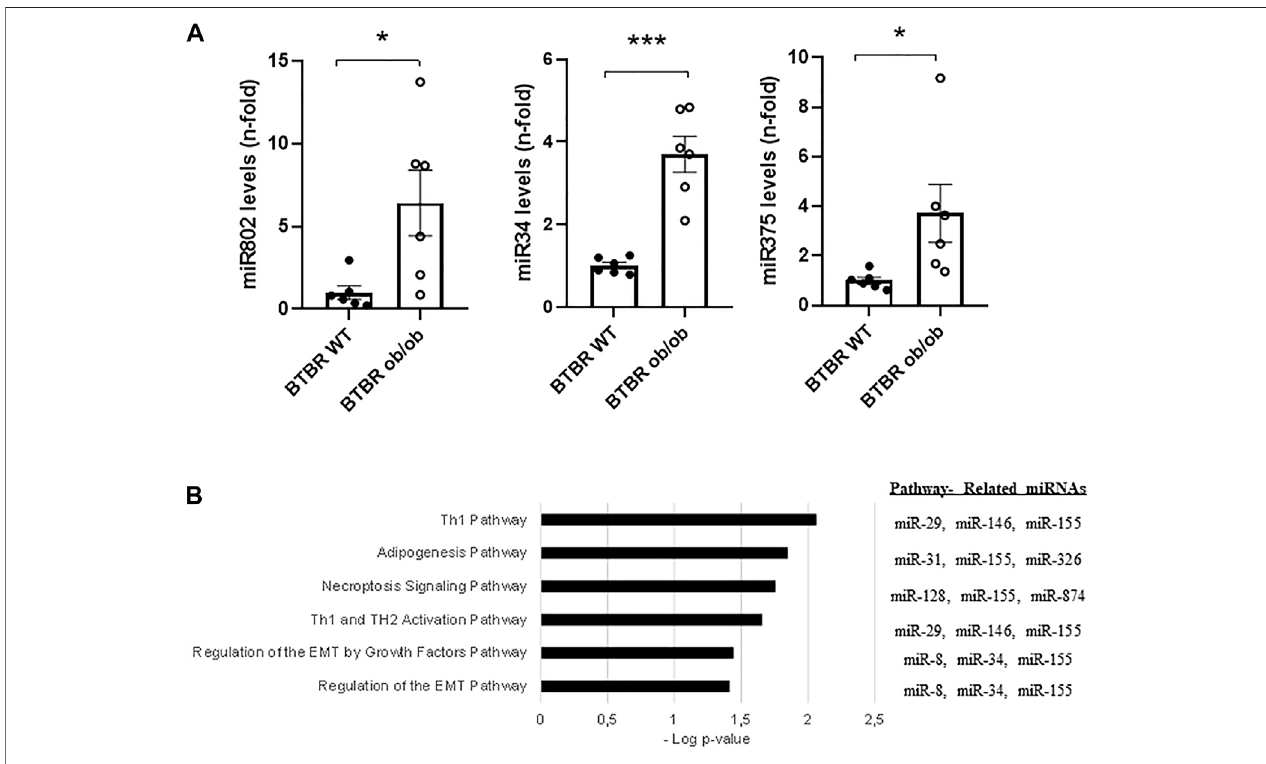
FIGURE 3 | miRNA RT-qPCR validation and assessment of key pathways and miRNAs. (A) miRNA relative expression (n-fold vs. BTBR WT) of miR802, miR34a, andmiR375. (B) Leftpanelshowsagraphicwiththetopcanonicalpathwaysrelatedtothe99miRNAsthatweresigni fi cantlypredictedinthecomparativeanalysisofthe cortexkidneyofBTBRob/obmicevs.BTBRWT,omittingcancerrelated pathways.Rightpanelindicatesthemostrelated miRNAstoeachpathway.Dataareshownas mean ± SEM and graphs bar with scatter dot plots of each group ( n = 6 mice/group). *** p < 0.001vs. BTBR WT; * p < 0.05 vs . BTBR